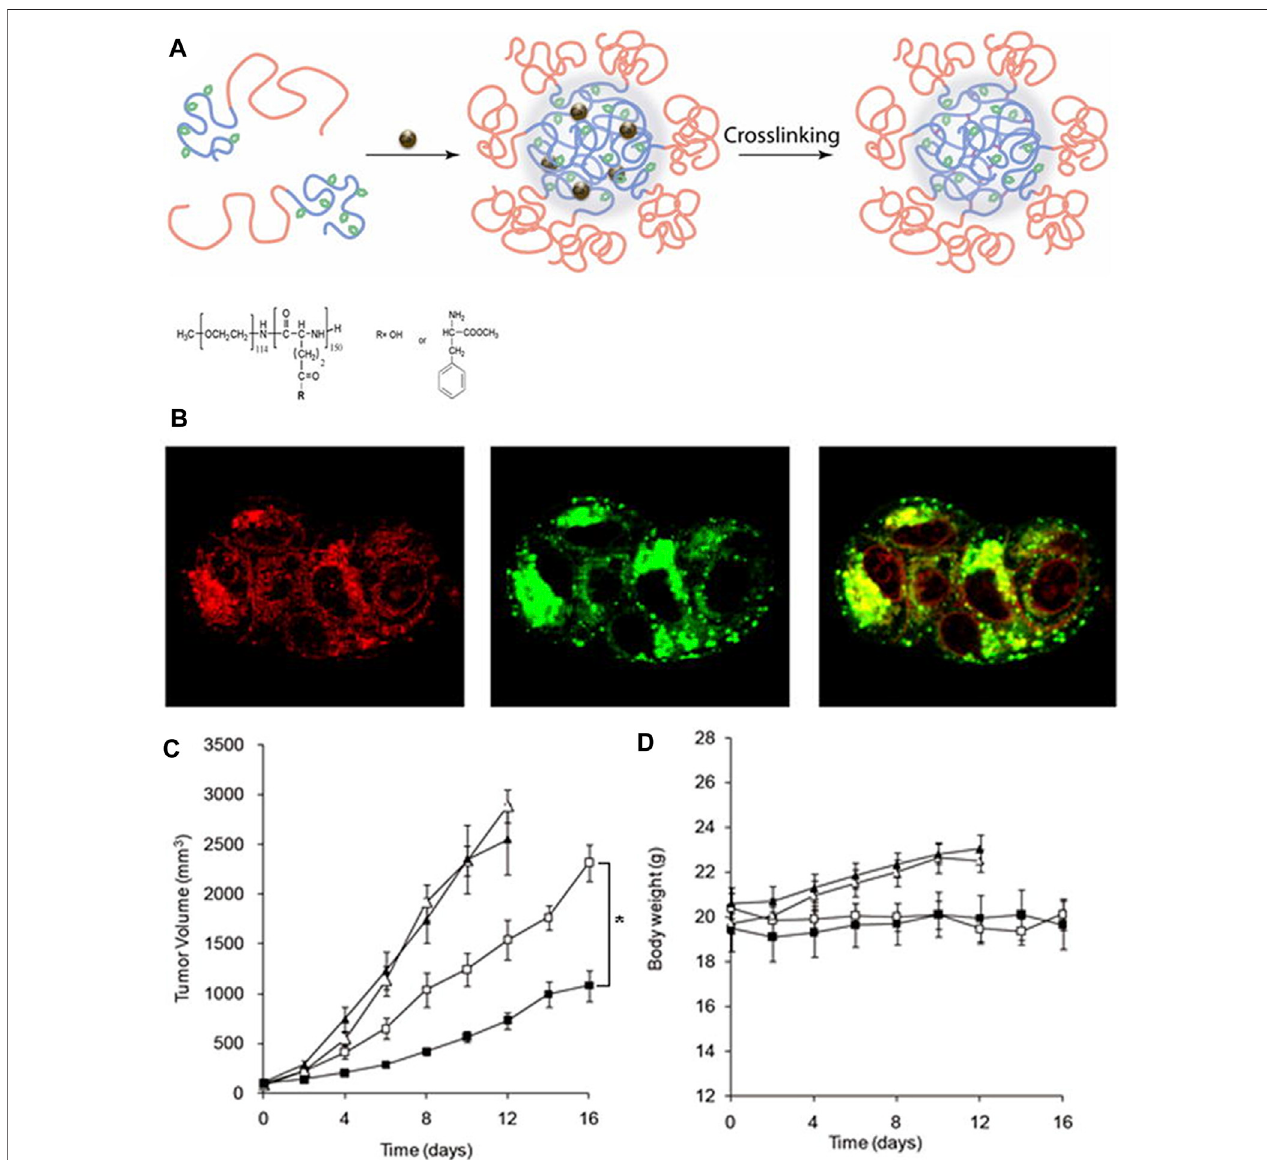
FIGURE9| Synthesisand biologicalcharacterization ofnanogels(Kim etal.,2013). (A) Schematic diagramofnanoparticleself-assembly. (B) Localization ofDOX- loaded nanogels in cells. Effects of DOX-loaded nanogels on the tumor volume (C) and body weight (D) .